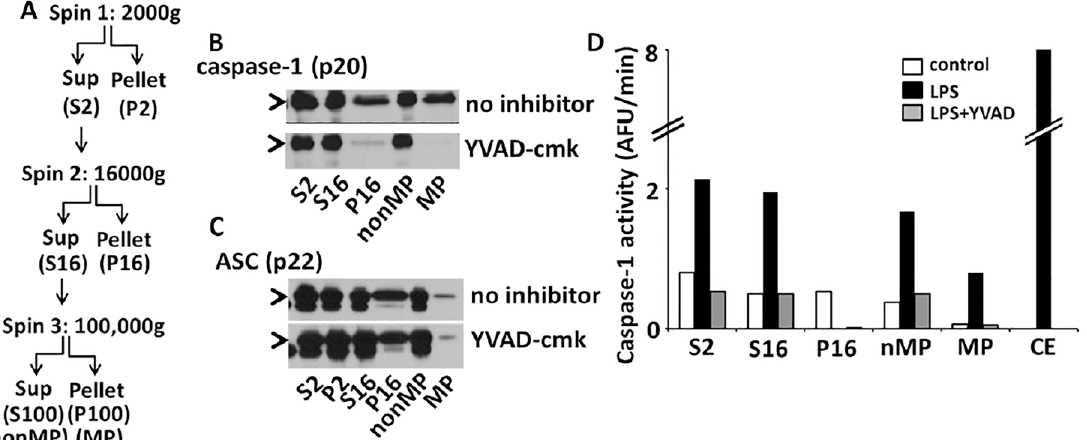
Fig 3. Active caspase-1 and ASC release in microparticles from stimulated THP-1. THP1 cells were stimulated with LPS (1 μ g/ml) for 2h in the presence or absence of YVAD-cmk. Microparticles were isolated from LPS stimulated THP-1 supernatant by stepwise ultracentrifugation (A). The cell fraction was separated by centrifugation at 2000 g for 5 min. Supernatants were then further fractionated into a 16,000g fraction followed by microparticle (MP) fraction and non- microparticle (nonMP) fraction by a final ultracentrifugation at 100,000 g for 1h. Microparticles (MP) and non-microparticle fractions (nMP) were analyzed for presence of the p20 form of caspase-1 (B) and the inflammasome adaptor protein, ASC (C) by immunoblot. Substrate cleavage capacity of caspase-1 from each of the supernatant fraction was also measured using WEHD-enzymatic assay (D). Analysis for n = 2